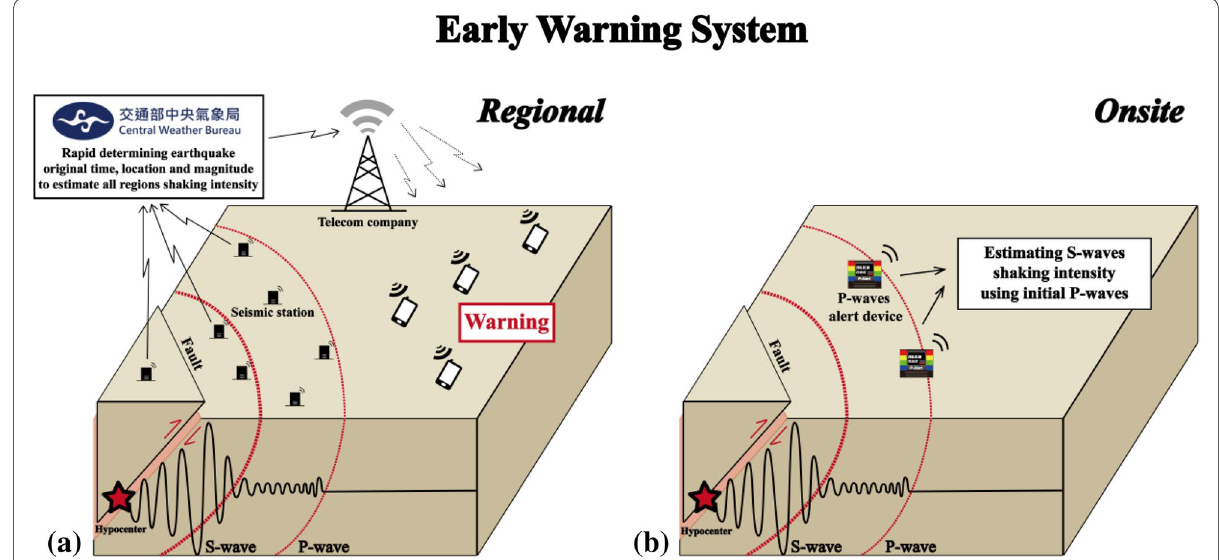
Fig. 2 a Concept of the regional earthquake early warning system operated by the Central Weather Bureau, Taiwan. b Concept of the onsite earthquake early warning